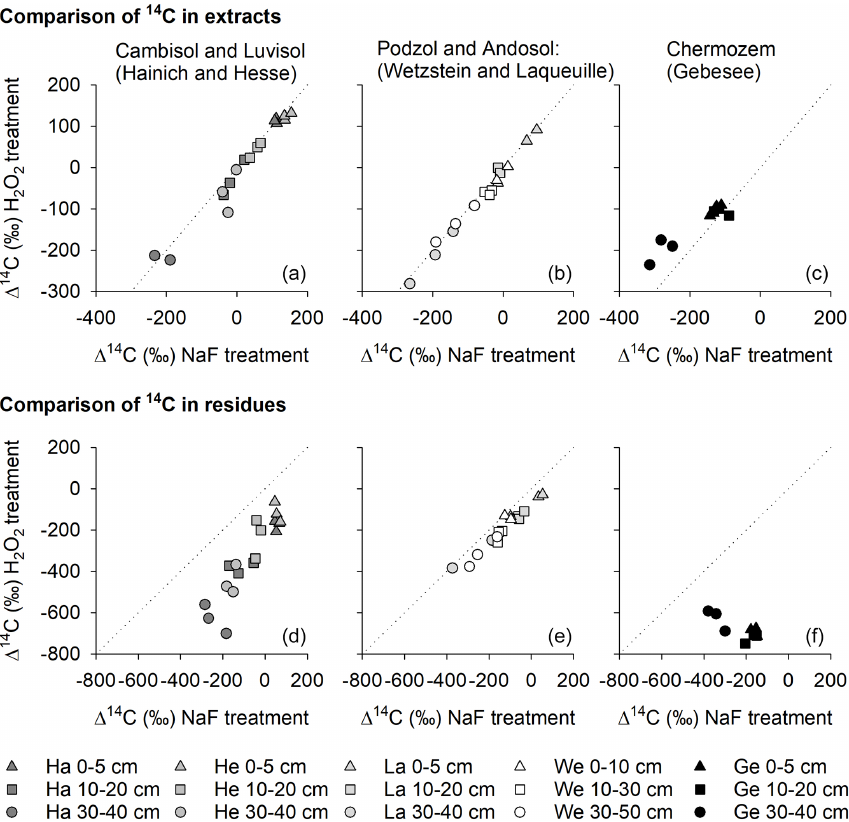
Figure 8. Relationships between the radiocarbon content of OC removed from mineral surfaces by H 2 O 2 and NaF–NaOH (a–c) and the radiocarbon content of OC residues after treatment with H 2 O 2 and NaF–NaOH (d–f) for the Hainich (Ha), Hesse (He), Laqueuille (La), Wetzstein (We), and Gebesee (Ge) study